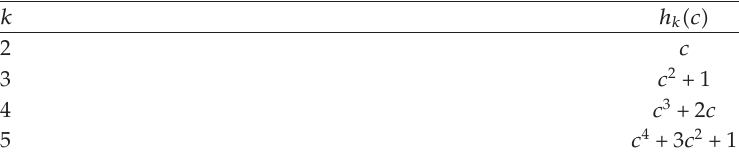
Table 5: Expression of h k (cid:2) c (cid:4) when α (cid:3) −